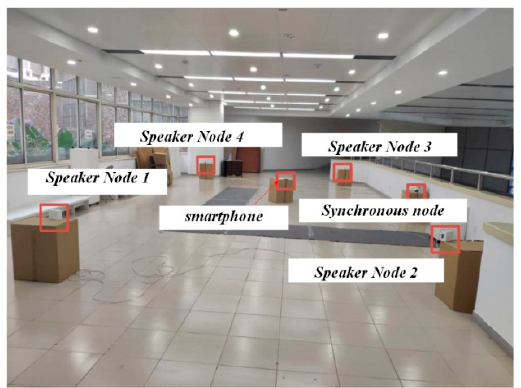
Figure 8. Photo of experimental setup.